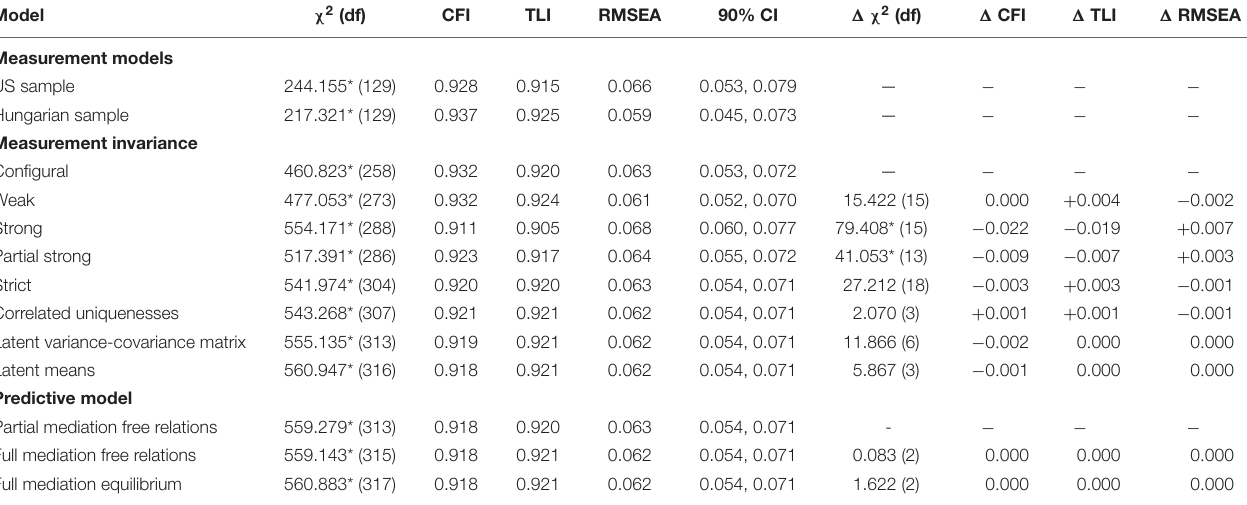
TABLE 1 | Invariance testing of the measurement and structural models across countries.